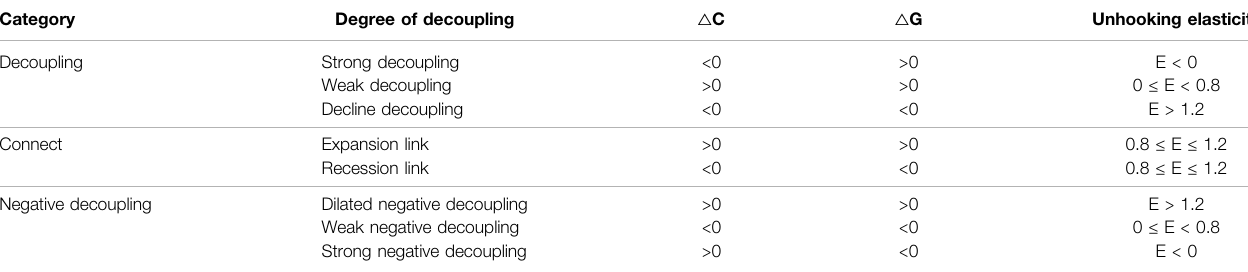
TABLE 1 | Decoupling elasticity and degree.